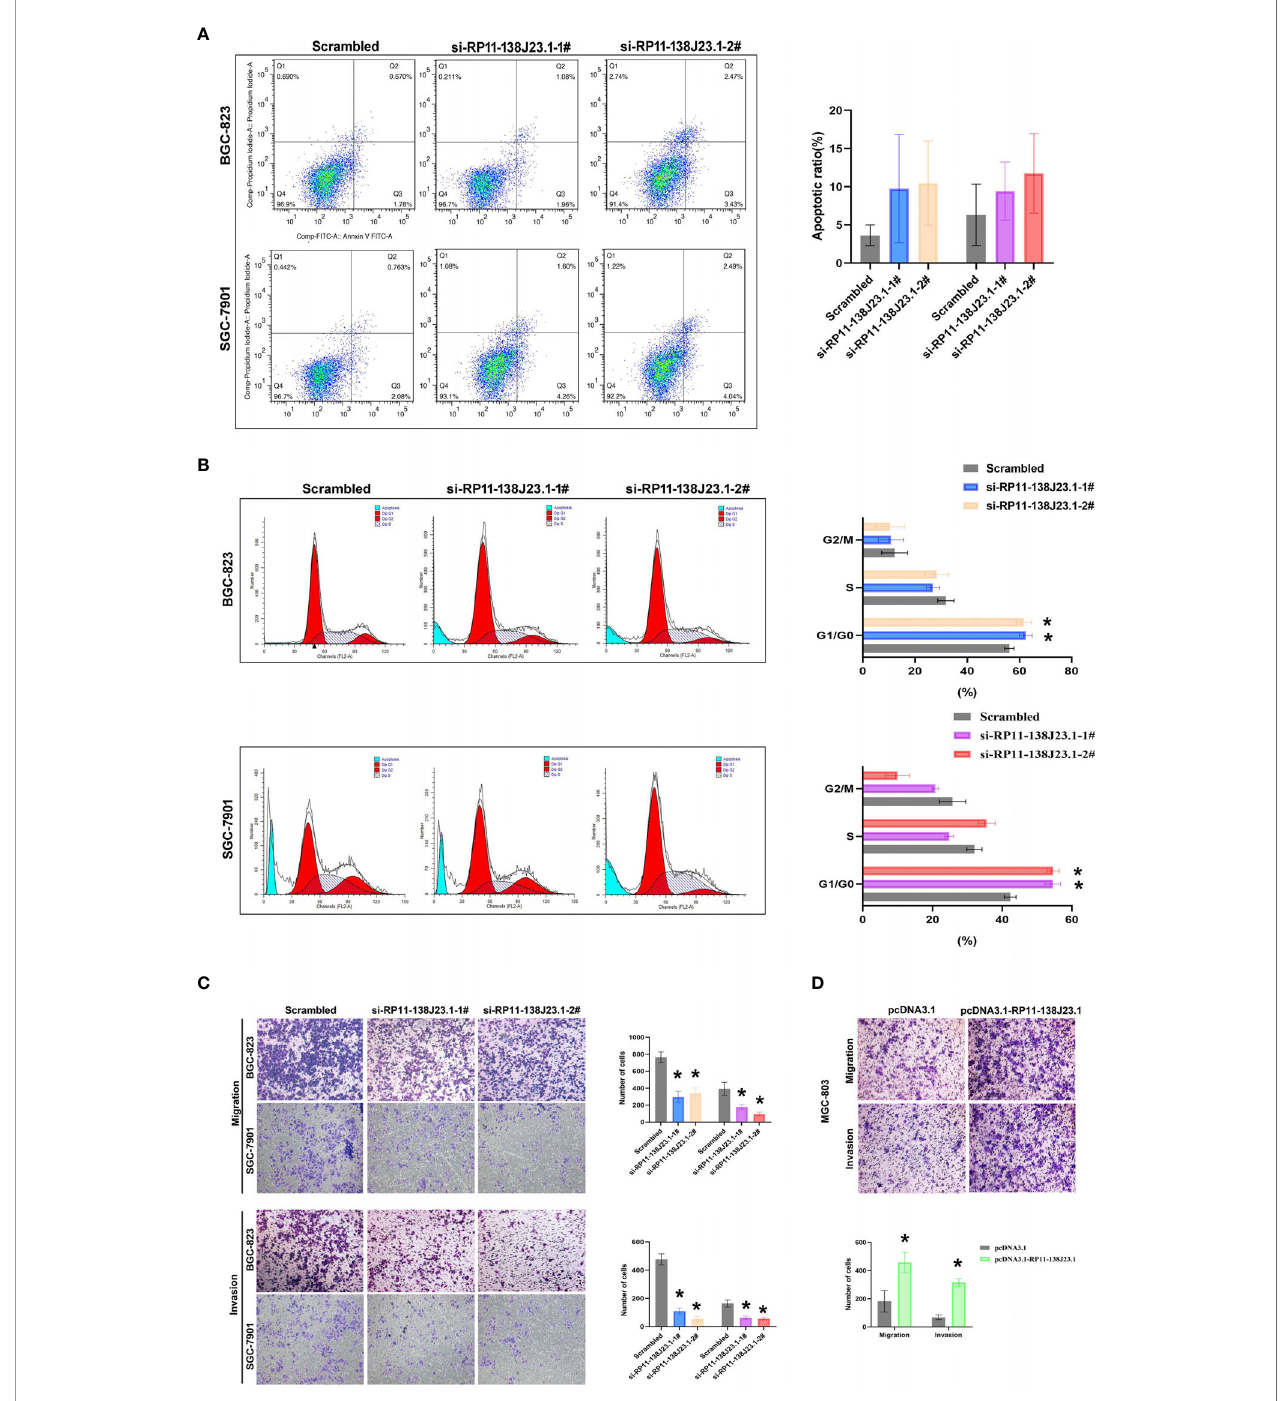
FIGURE 4 | The effects of RP11-138J23.1 on GC cell apoptosis, cell cycle, cell migration, and invasion in vitro . (A) The apoptosis of BGC-823 and SGC-7901 were analyzed by fl ow cytometry. LR, early apoptotic cells; UR, terminal apoptotic cells. (B) Flow cytometry assays were performed to analyze the cell cycle progression when GC cells were transfected with RP11-138J23.1. (C) Transwell assays were used to determine the cell metastatic ability of si-RP11-138J23.1 1#, si-RP11- 138J23.1 2#, or scrambled transfected BGC-823 and SGC-7901 cells. The cells on the lower chamber were stained and presented. (D) Transwell assays were used to determine the cell metastatic ability of pcDNA3.1 RP11-138J23.1 and empty-vector-transfected MGC-803 cells. Data represent the mean ± SD from three independent experiments. * p < 0.05. NS, not signi fi